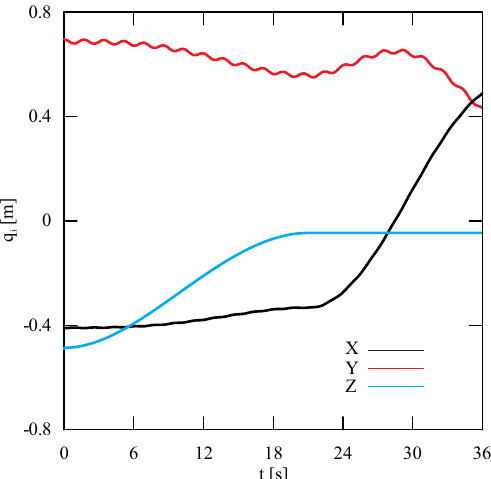
Figure 7. Change of generalized coordinates as a function of time.